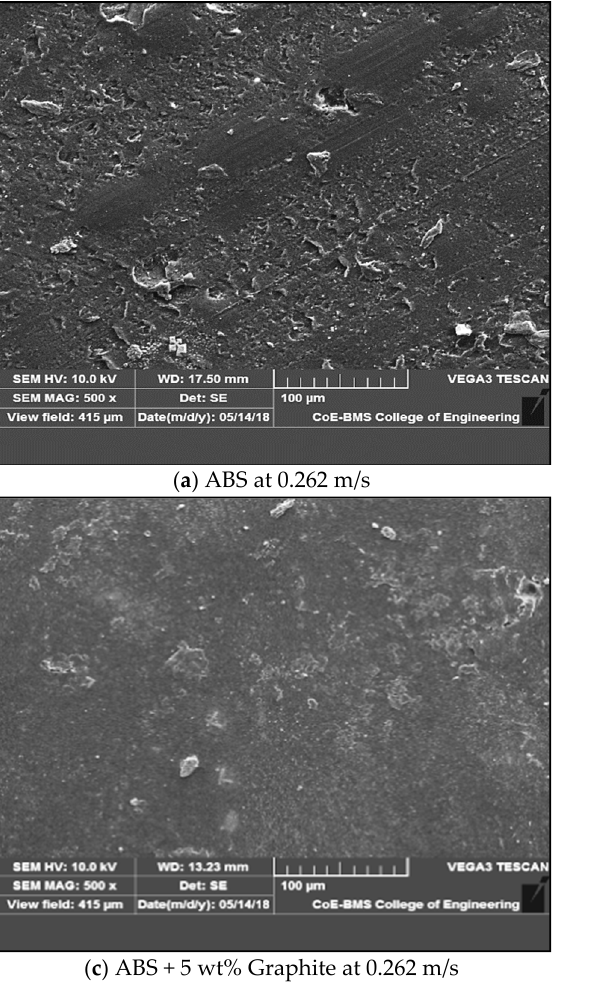
Figure 9. Scanning electron micrographs of the wear test specimens showing the morphology the worn out surfaces after the friction and wear test at different sliding velocities; ( a ) ABS at 0.262 m/s; ( b ) ABS at 1.05 m/s; ( c ) ABS + 5 wt% graphite at 0.262 m/s; ( d ) ABS + 5 wt% graphite at 1.05m/s.